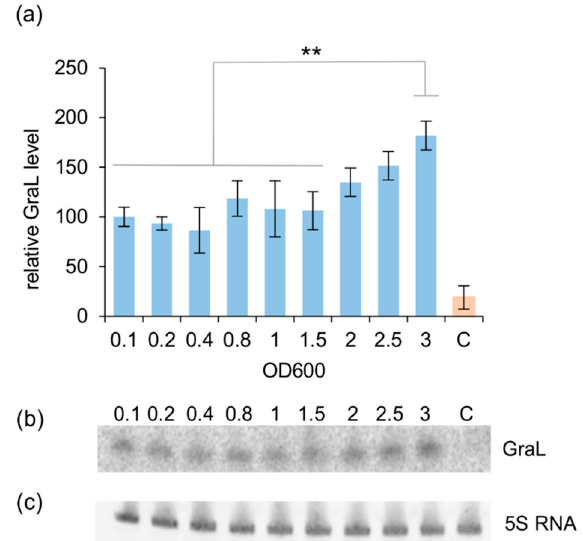
Figure 4. GraL levels monitored throughout bacterial growth. ( a ) GraL levels established by Northern blot analysis at OD 600 ′ s indicated; data were normalized to 5S RNA levels; the Δ lacZ Δ greA Δ GraL strain (ECMZ1604) served as control, the sample was taken at OD 600 ~ 0.9 [C — in orange]. Growth of E. coli Δ lacZ (CF15617) was carried out in LB at 32 °C with aeration. Experiments were done in triplicate. Error bars represent S.D. Calculated p -values are indicated (** p < 0.005); ( b ) representative image of Northern blot with GraL visualized; ( c ) representative image of Northern blot with 5S RNA visualized.